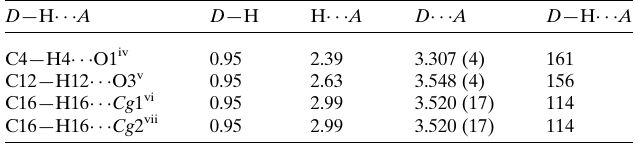
Table 1 Hydrogen-bond geometry (A˚ , (cid:5) ). Cg 1 and Cg 2 are the centroids of the C2–C5/C5 vii /C6 vii and C5/C6/C2 vii –C5 vii rings, respectively. D —H (cid:3)(cid:3)(cid:3) A